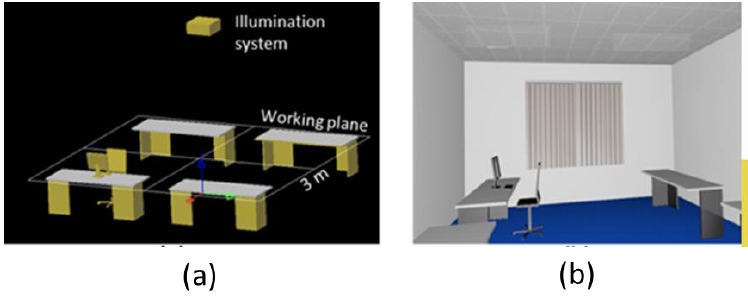
Figure 11. ( a ) Simulation configuration for indoor lighting; ( b ) visual image of the test room.